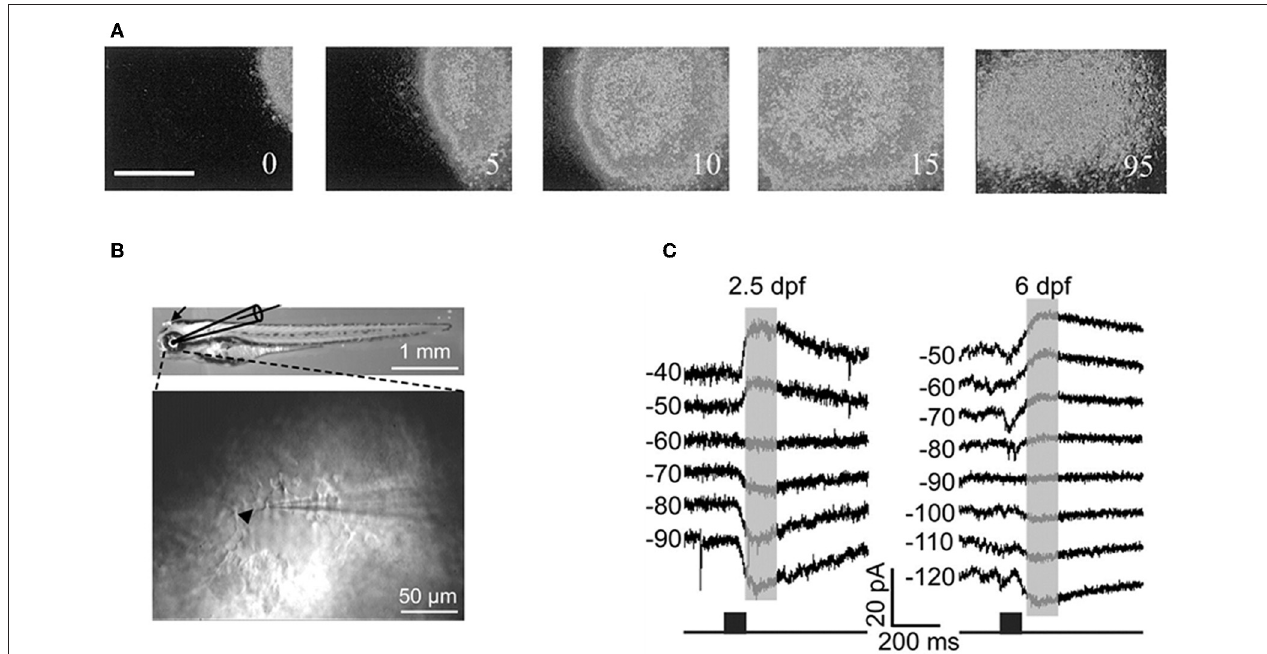
FIGURE 8 | GABA is excitatory in non-mammals retina both in vivo and in vitro . (A) Time-lapse images of a GABA-induced wave in a S25 turtle retina. [Modified from Sernagor et al. (2003)]. (B) Diagram of in vitro whole-cell recording in intact zebrafish larvae. Top: bright-field image of whole-body morphology of a 3dpf larva with removal of the lens (arrow). (C) GABA-induced currents recorded from two Retinal